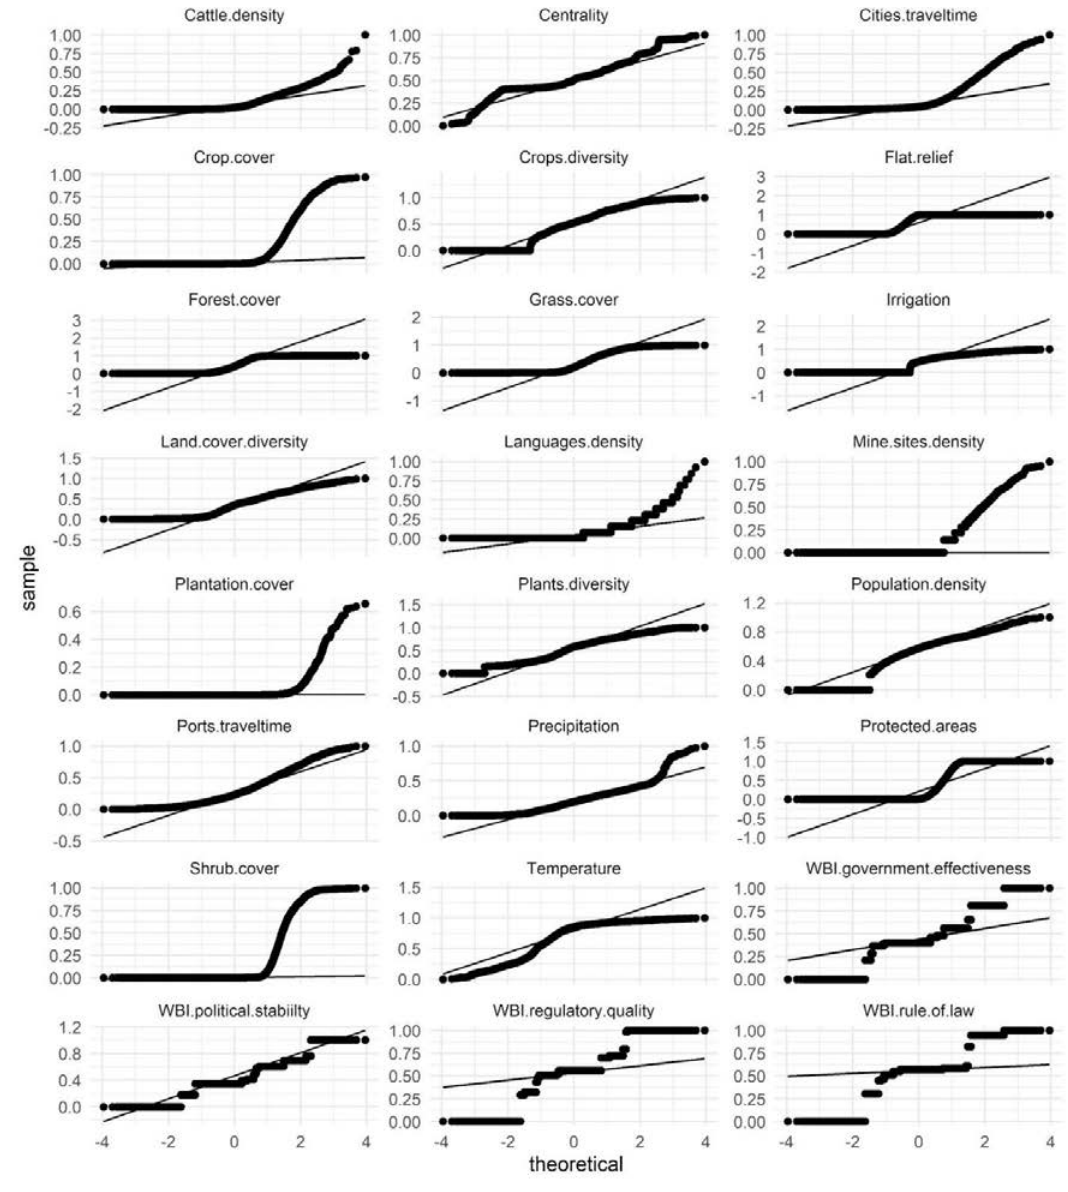
Figure A1.3 . Variables Quantile-Quantile plots. These plots allow us to visualize the deviation of each continuous variable from a theoretical normal distribution. If the values (thick dots) lie along the thinner line the distribution has the same shape as the theoretical normal